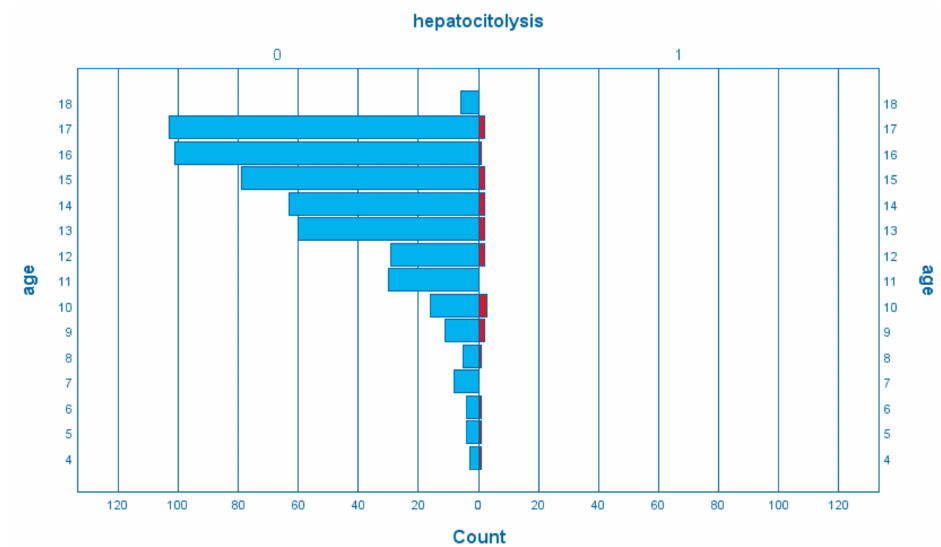
Figure 1. The structure of the group of patients according to age and the presence of hepatocytolysis (blue—absent,